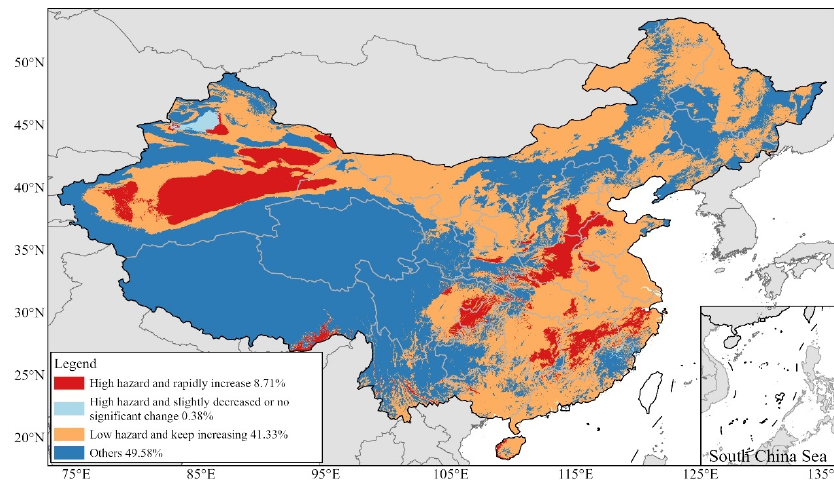
Figure 9. Heatwave classifications in China.